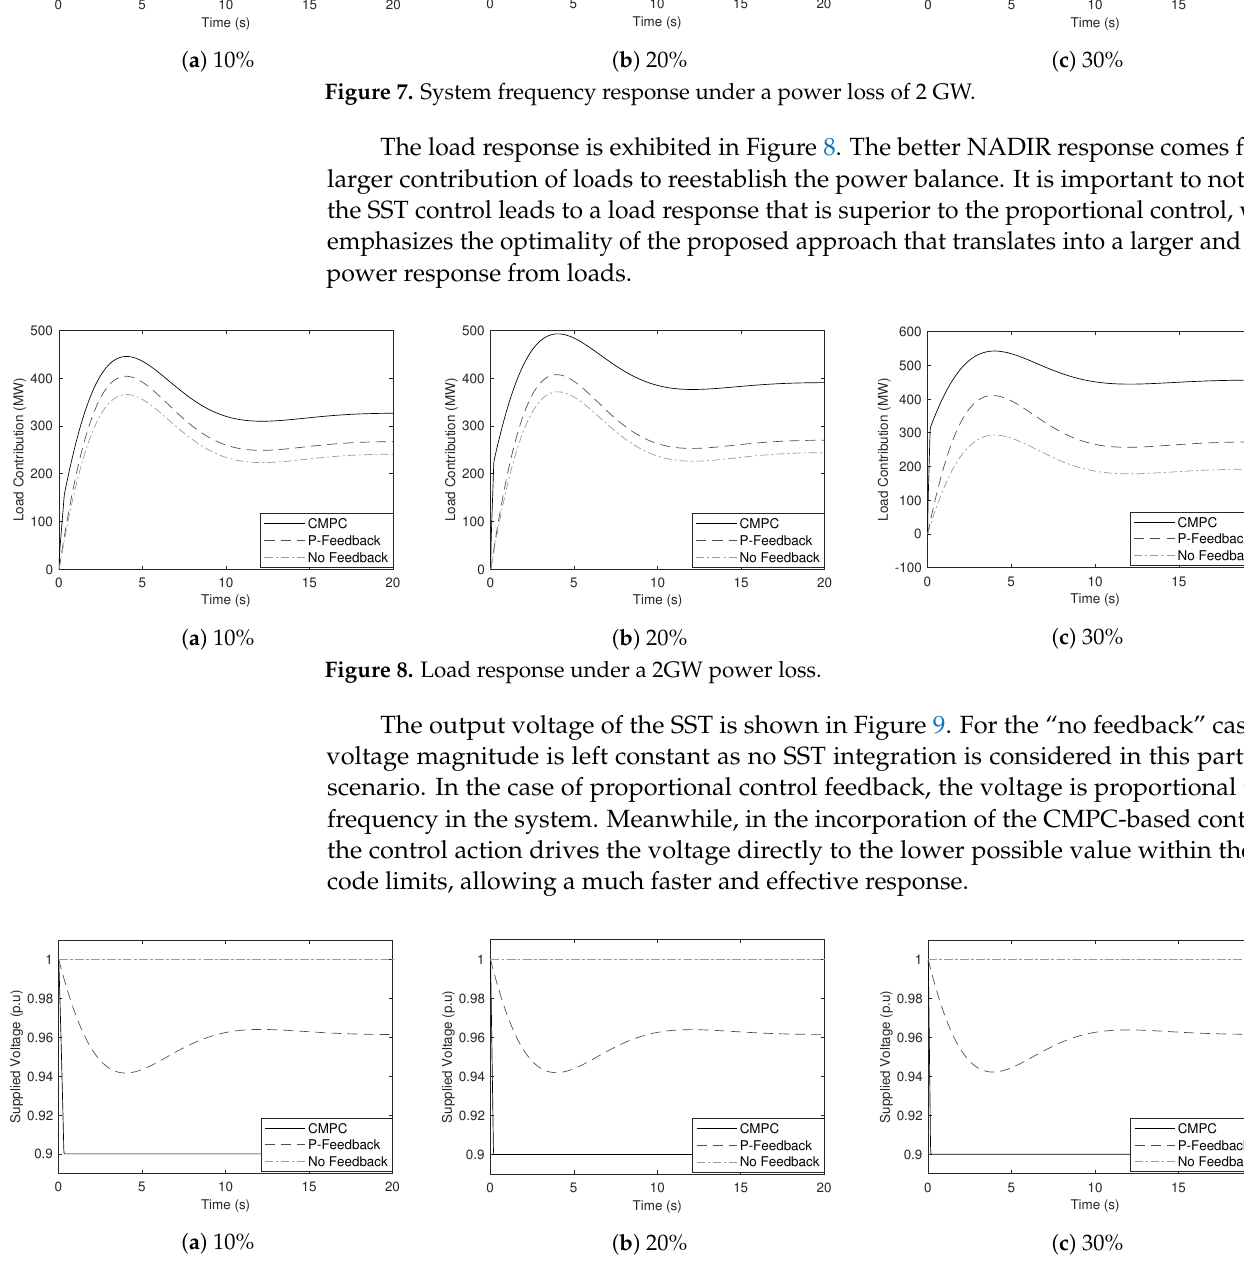
Figure 9. Supplied voltage under a 2GW power